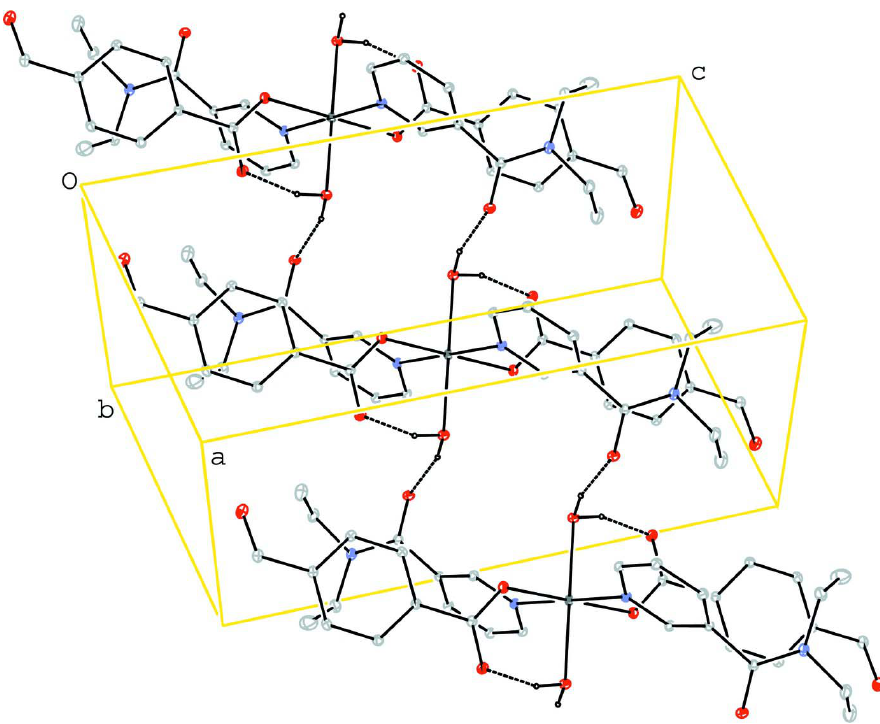
Figure 2 A partial packing diagram of the title compound, showing hydrogen bonds (dashed lines) linking the molecules through the R 2 (16) ring motif. H atoms not involved in hydrogen bonds are omitted for 2